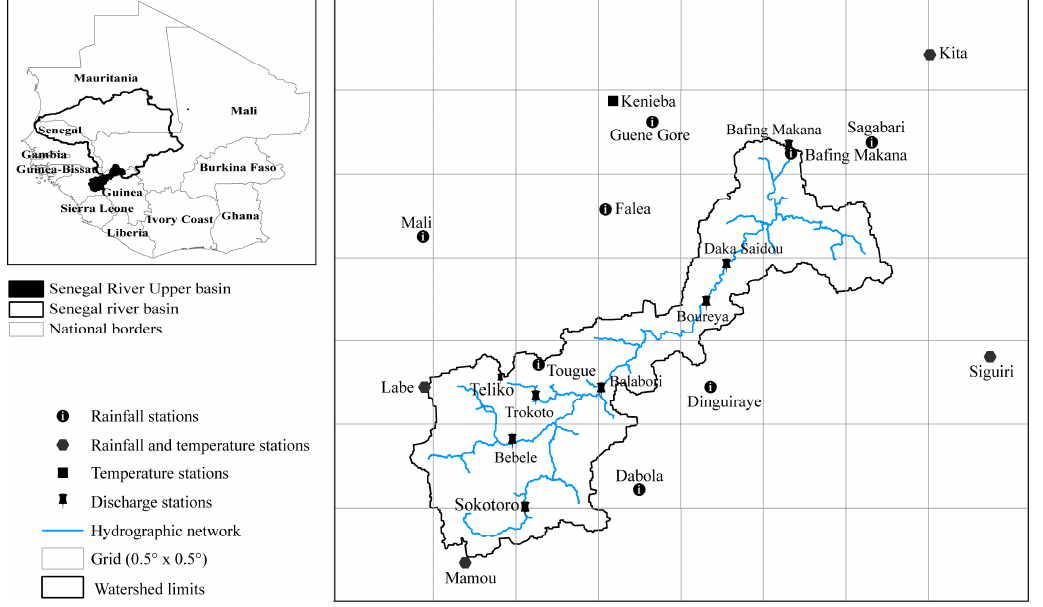
Figure 1. Location of the Senegal River upper basin, climate and hydrometric stations.